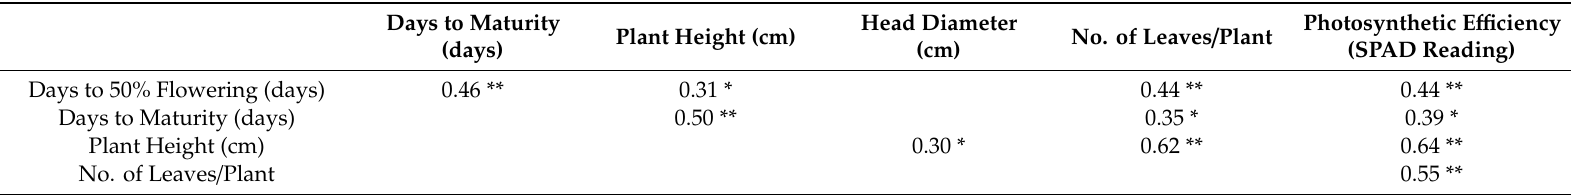
Table 8. Pearson’s correlation coe ffi cients of sunflower hybrids under water stress with only significant values at p < 0.05 (*) and p < 0.01